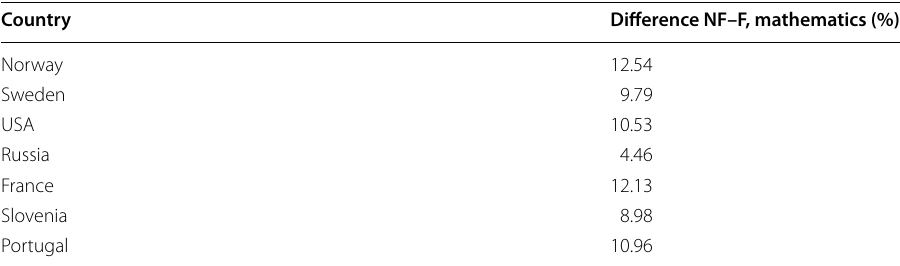
Table 9 Differences between average p -values for NF items and F items in TIMSS Advanced